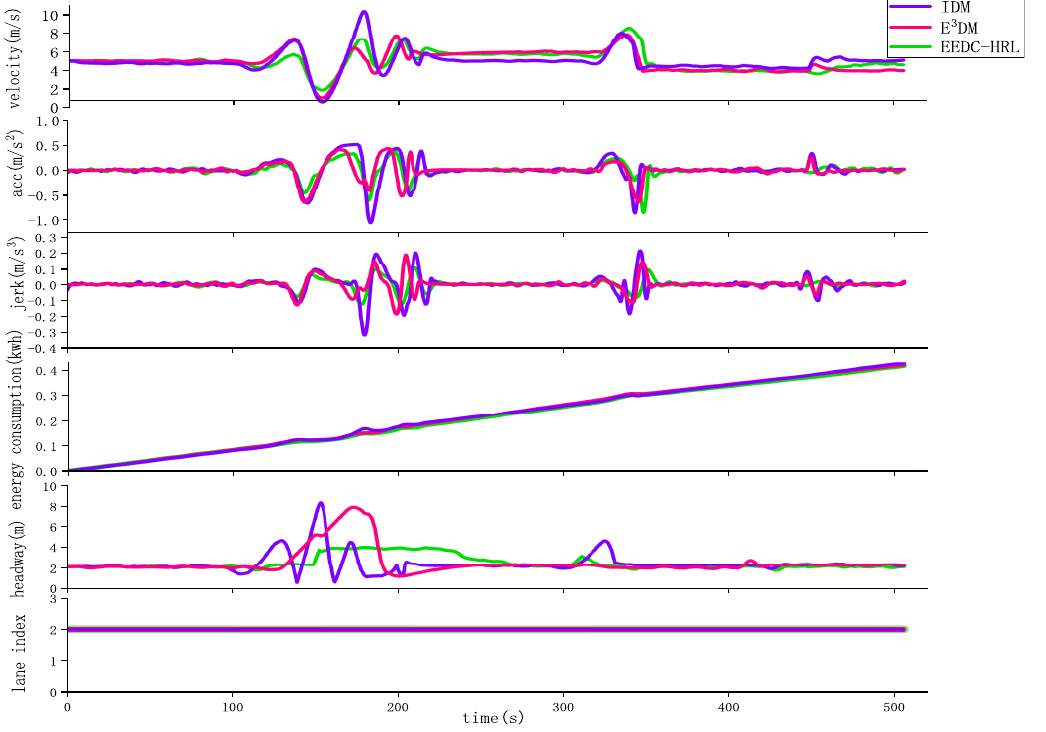
Figure 9 The sampled event in congested traf fi c